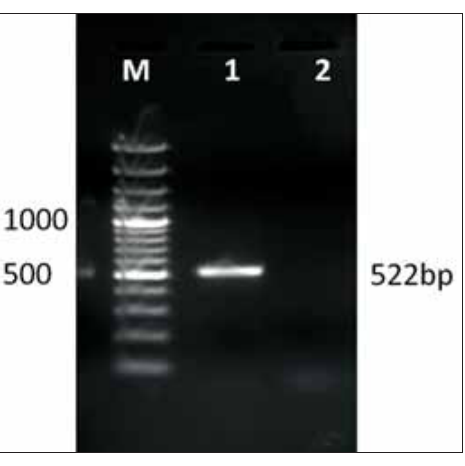
Figure-1: DNA electrophoresis of polymerase chain reaction (PCR) amplicons of 16S-23S rDNA spacer gene. M-DNA ladder, 1-PCR product, 2-Negative control.